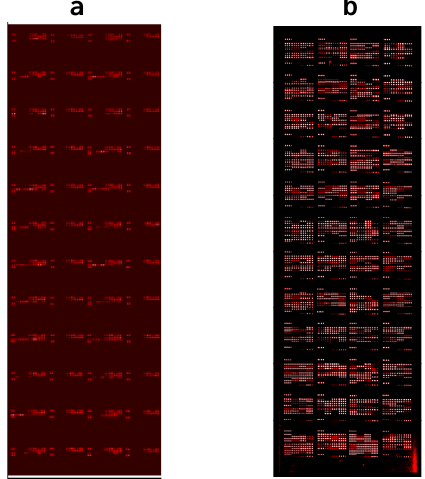
Figure 2. Pathogen proteome microarrays . Confocal laser scanner image of proteins spotted in duplicate onto microarray slides, visualized using a rabbit anti-GST antibody bound to Cy5-labeled anti-rabbit antibody. ( a ) Vaccinia virus; ( b ) Yersinia pestis. a